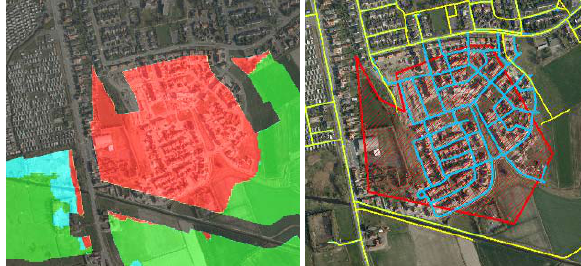
Figure 8: Redevelopment detection; Left: no contradictions to the database = green, irrelevant contradictions = blue, contradicting regions denoting impervious surface = red; Right: current road data = yellow, roads required to be updated = blue, methods outcome = red